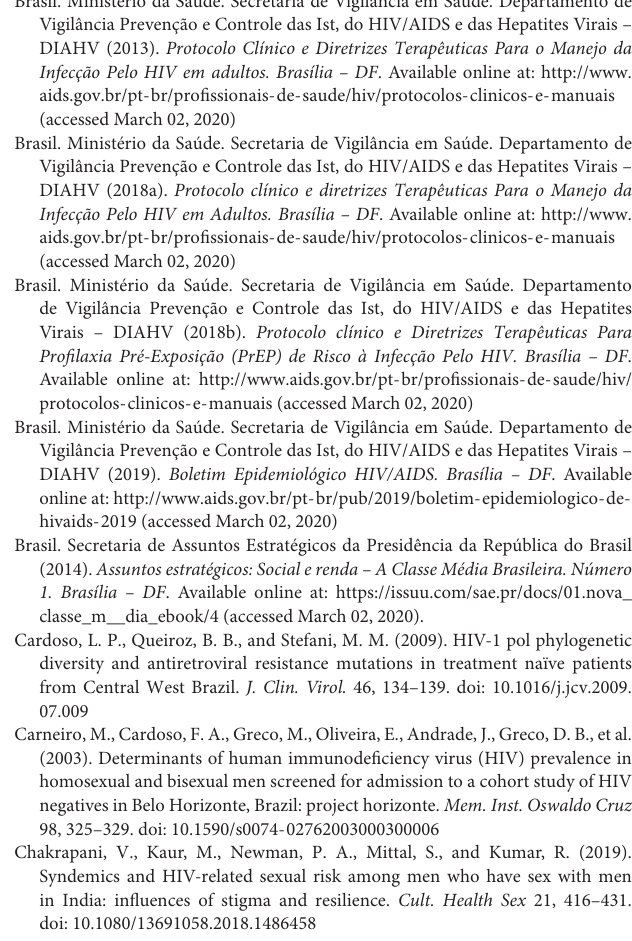
Supplementary Figure 1 | Maximum likelihood (ML) phylogenetic tree of HIV-1 subtype B pol sequences ( ∼ 1,000 nt) from MSM individuals from Goiás described in the present study (red branches), combined with subtype B sequences from Goiás (blue branches) and other Brazilian states (black branches) that were available at the Los Alamos HIV Sequence Database. Shaded boxes highlight the position of the subtype B monophyletic clusters ( a LRT > 0.75) containing sequences from MSM from Goiás here described. Tree was rooted on midpoint. The branch lengths are drawn to scale with the bar at the bottom indicating nucleotide substitutions per site. Supplementary Figure 2 | Maximum likelihood phylogenetic tree of HIV-1 subtype F-1 pol sequences ( ∼ 1,000 nt) from MSM individuals from Goiás described in the present study (red branches), combined with subtype F1 sequences from Goiás (blue branches) and other Brazilian states (black branches) that were available at the Los Alamos HIV Sequence Database. Shaded boxes highlight the position of the subtype F1 monophyletic cluster ( a LRT = 0.95) containing most sequences from MSM from Goiás here described. Tree was rooted on midpoint. The branch lengths are drawn to scale with the bar at the bottom indicating nucleotide substitutions per